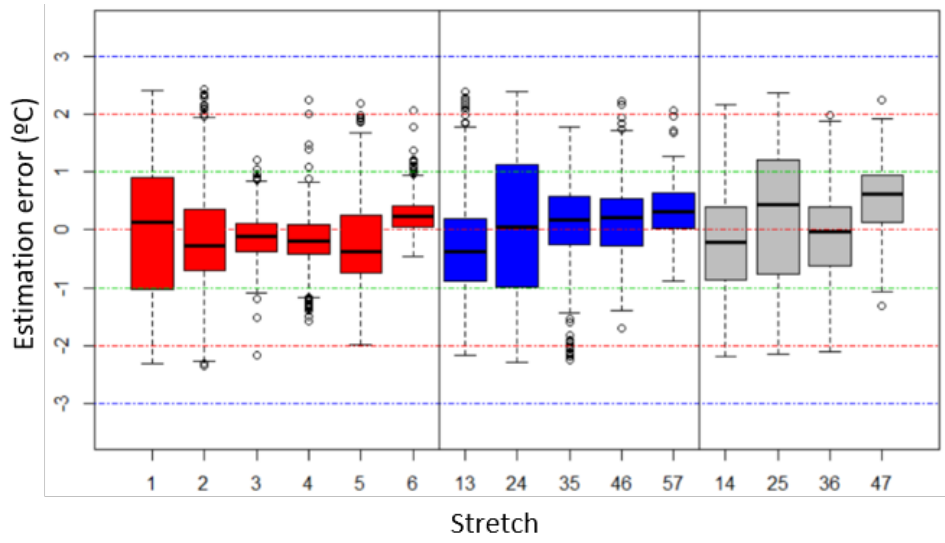
Figure 6. Error distribution as a function of stretch, node-to-node (red), and multi-node lag steps (blue represents two steps and gray represents three steps).